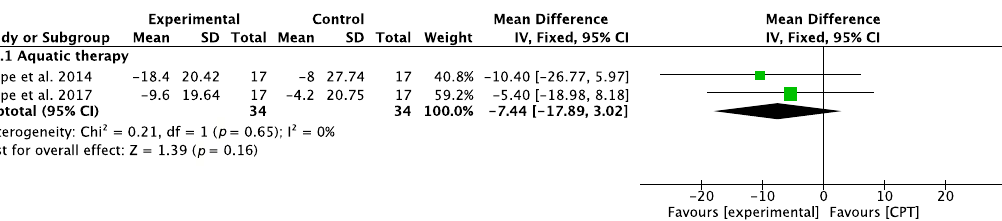
Figure 7. Forest plot for quality of life measured by PDQ-39. Green block indicates the weight assigned to the study and the horizontal line depicts the confidence interval. Black rhombus shows the overall result. The bold words highlight the total/subtotal values and the different modalities of therapies used in the interventions.